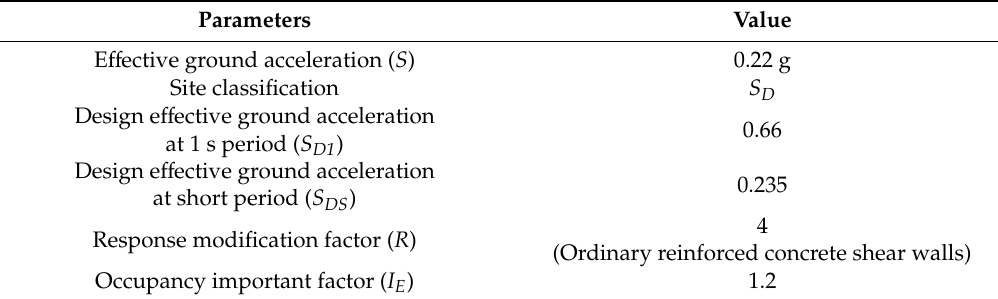
Table 3. Seismic load parameters